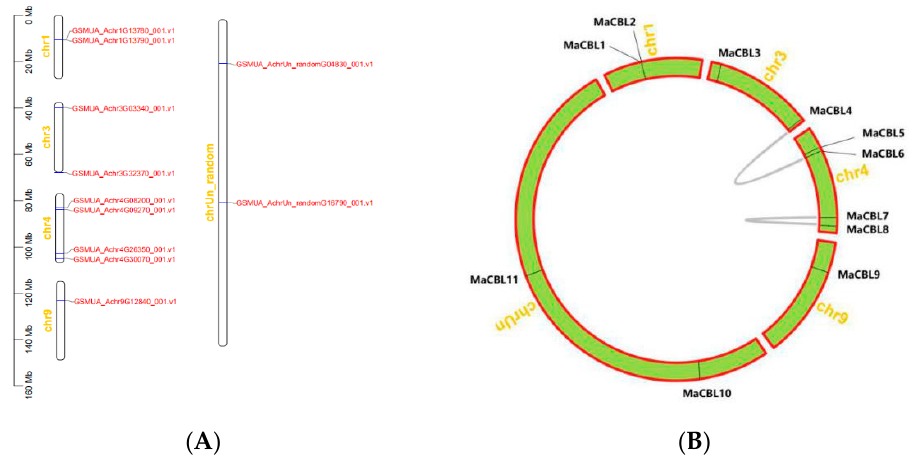
Figure 3. Distribution of CBL genes on chromosomes in bananas ( A ) and the syntenic relationships ( B ) of CBL genes.